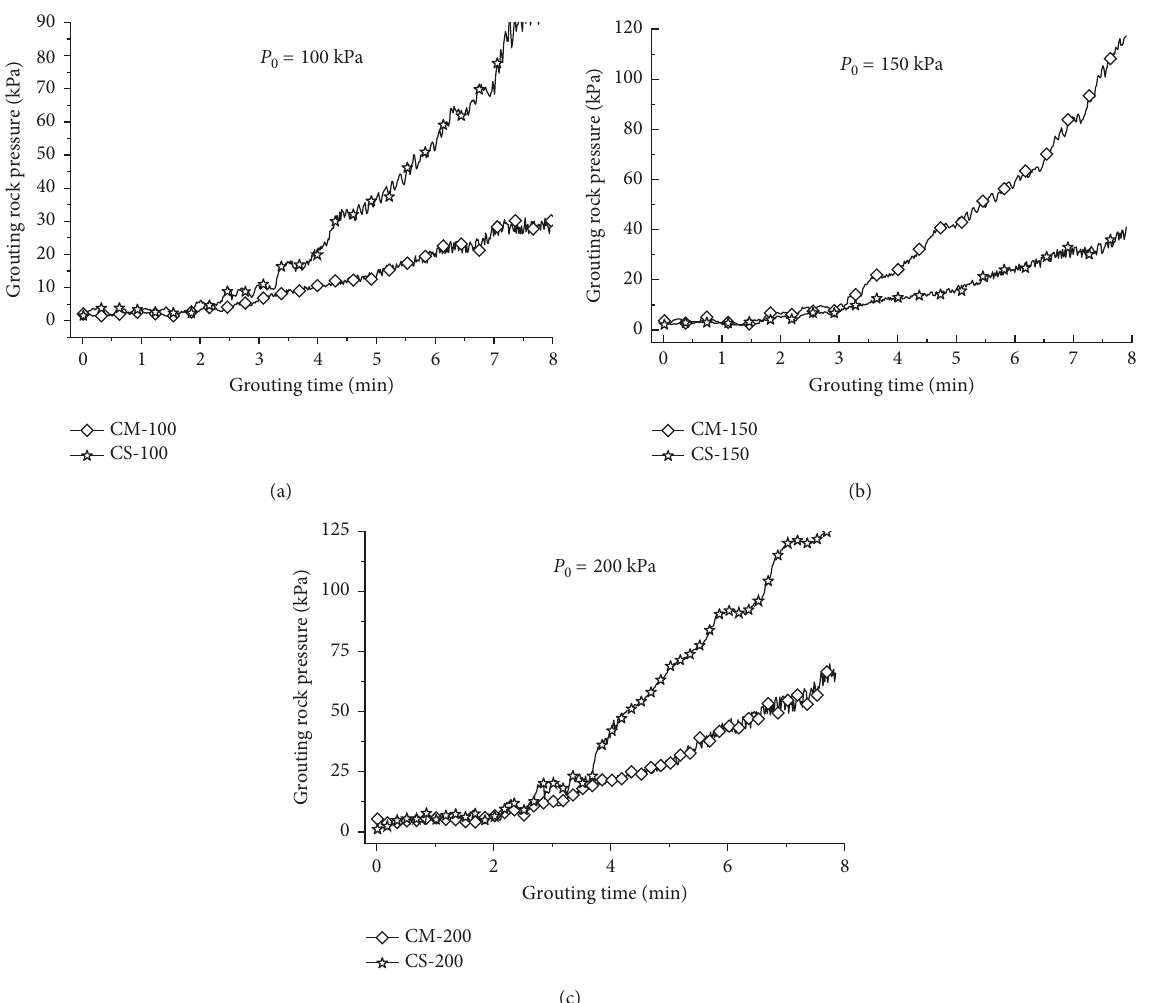
0 (cid:30) 100 kPa, (b) initial pressure P 0 (cid:30) 150kPa, and (c) initial